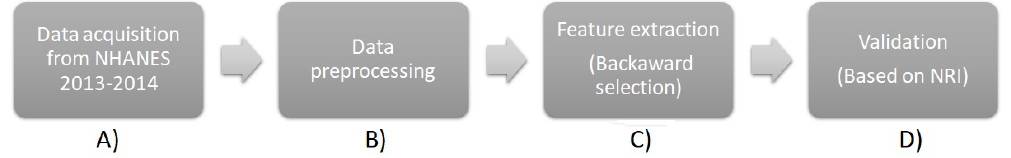
Figure 1. Flowchart of the steps followed in methodology. NHANES: National Health and Nutrition Examination Survey; NRI: net reclassification